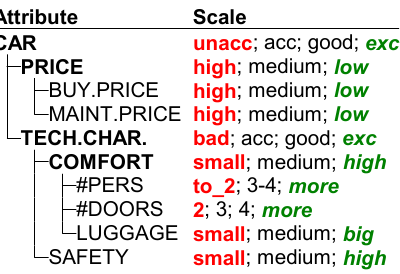
Figure 2. Structure and value scales of a DEX decision model for the evaluation of vehicles [8].